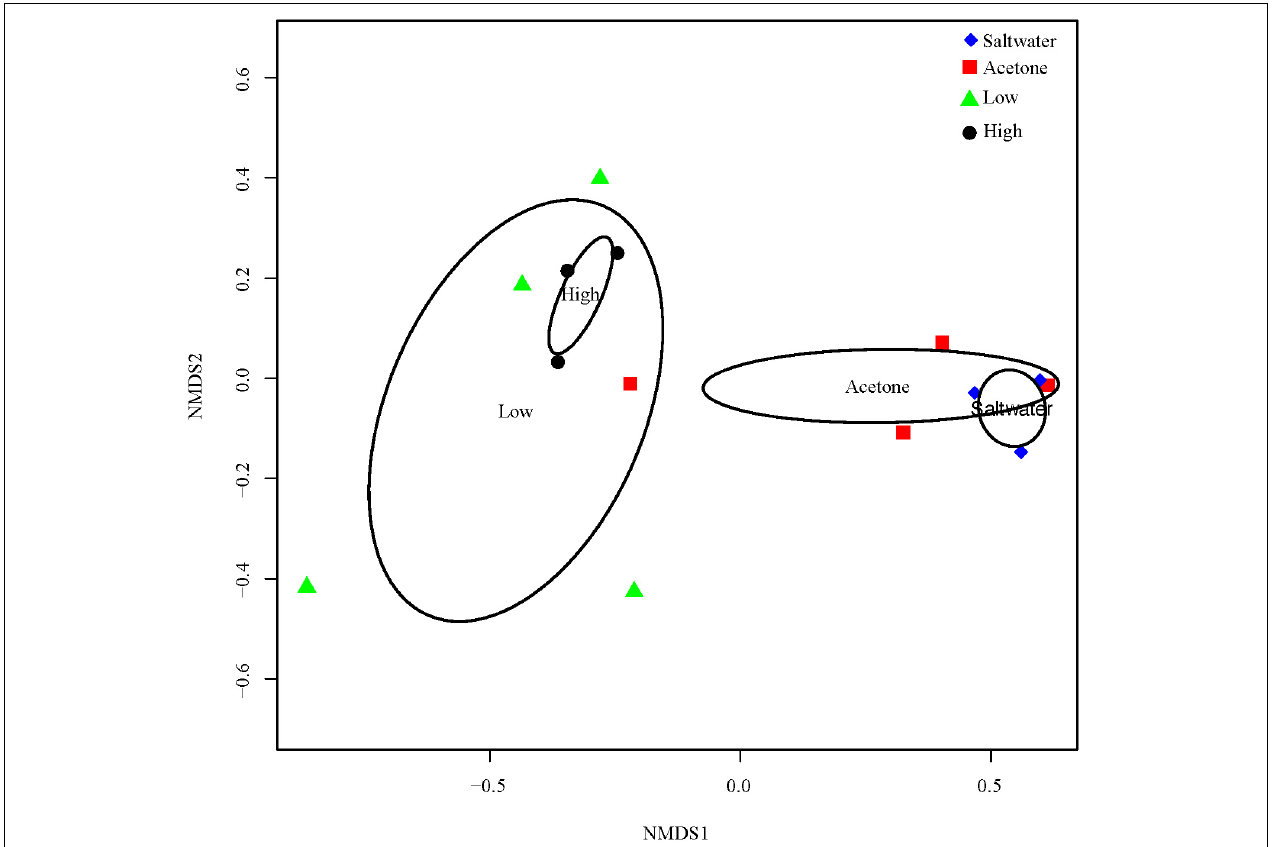
FIGURE 1 | Nonmetric dimensional scaling (NMDS) of microbiome reads from M. cavernosa tissue samples. “High” indicates samples that were dosed with a concentration of 1.93 mg/l of permethrin 24 h prior to sampling. “Low” indicates samples that were dosed with a concentration of 0.33 mg/l of permethrin. “Acetone” represents the coral that was dosed with 5 ml/l of acetone to match the acetone concentration used to dilute the permethrin in permethrin-treated aquaria. “Seawater” controls were dosed with seawater from the controlled flow-through system to account for a control